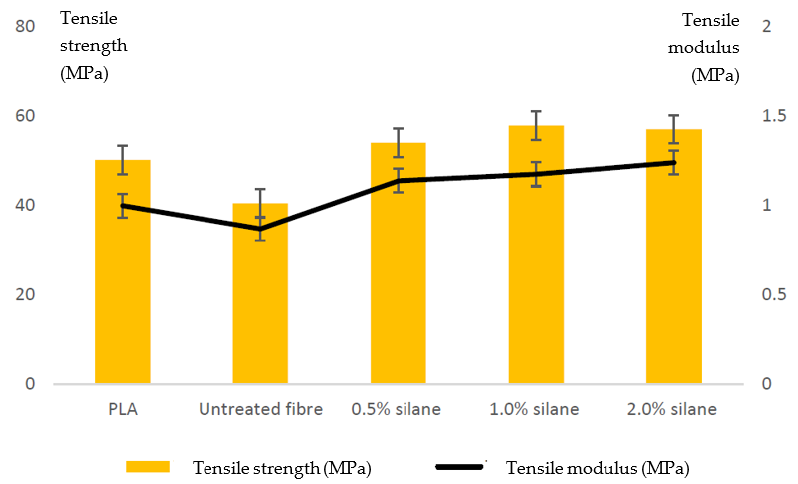
Figure 25. Results of composite tensile tests [164].